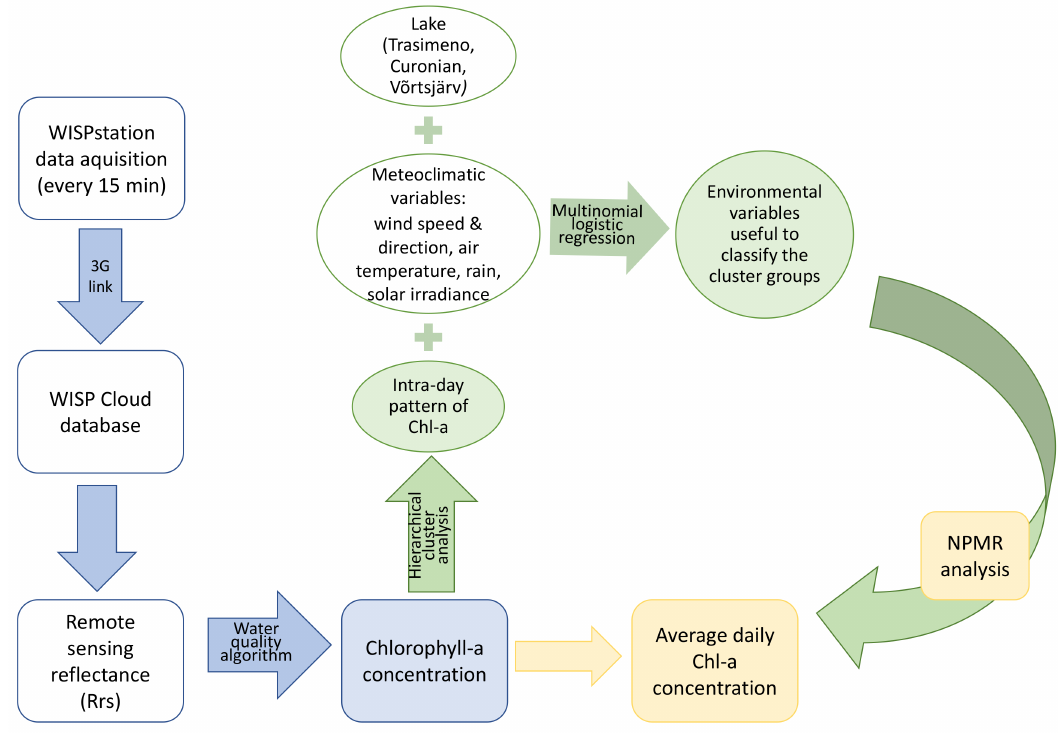
Figure 3. Schematic diagram of data acquisition and analysis carried